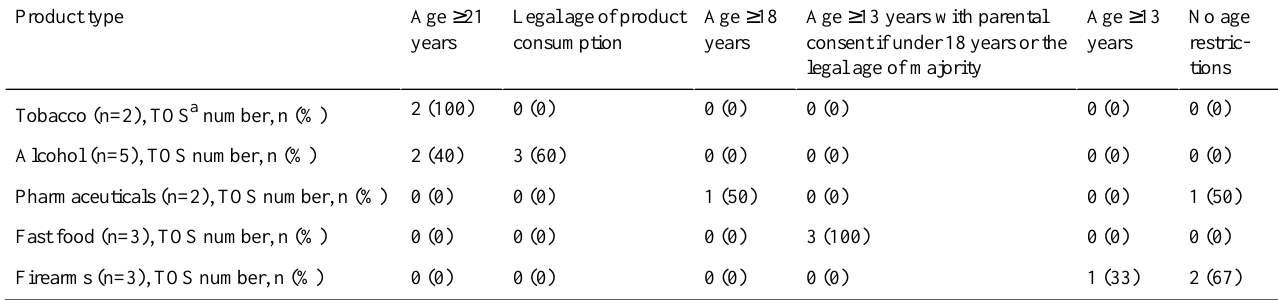
Table 2. Number of websites with age restriction on website access.